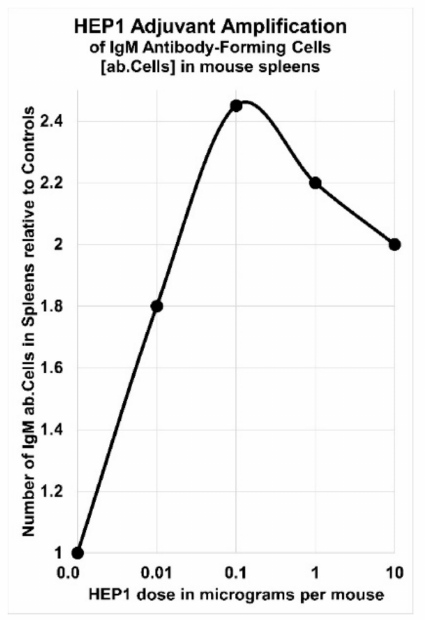
Figure 8. Immuno-adjuvant activity (measured as the number of IgM antibody-forming cells in spleens of mice, relative to control mice) as a result of intraperitoneal injection of 4 different doses of HEP1 (0.001, 0.01, 0.1, 1 and 10 µ g per mouse) plotted in